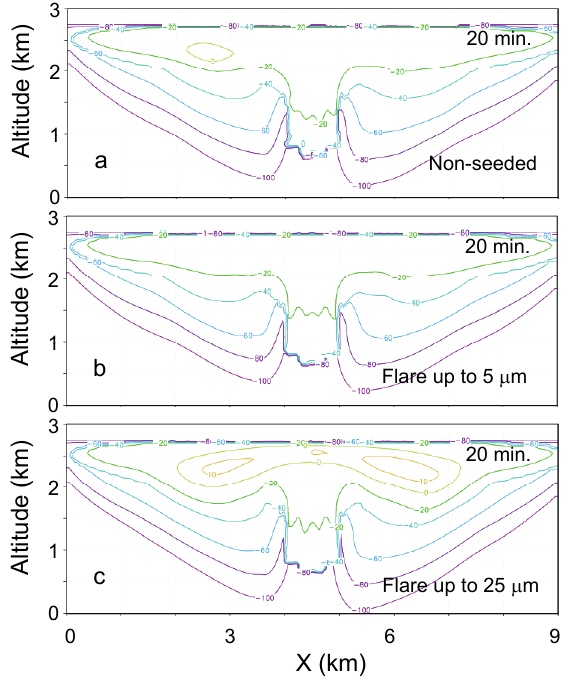
Fig. 15. Same as Fig. 14 except at 30min. Fig. 16. Radar reflectivity in shallow convective cloud at 20min for the non-seeded case (a) and seeded cases with flare particles